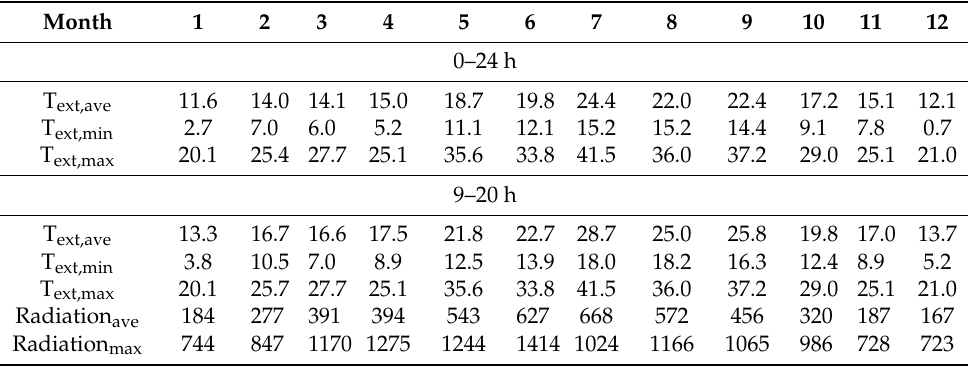
Table A1. Monitored local environmental conditions in 2020 [38.772 ◦ N, 9.178 ◦ W]. Month